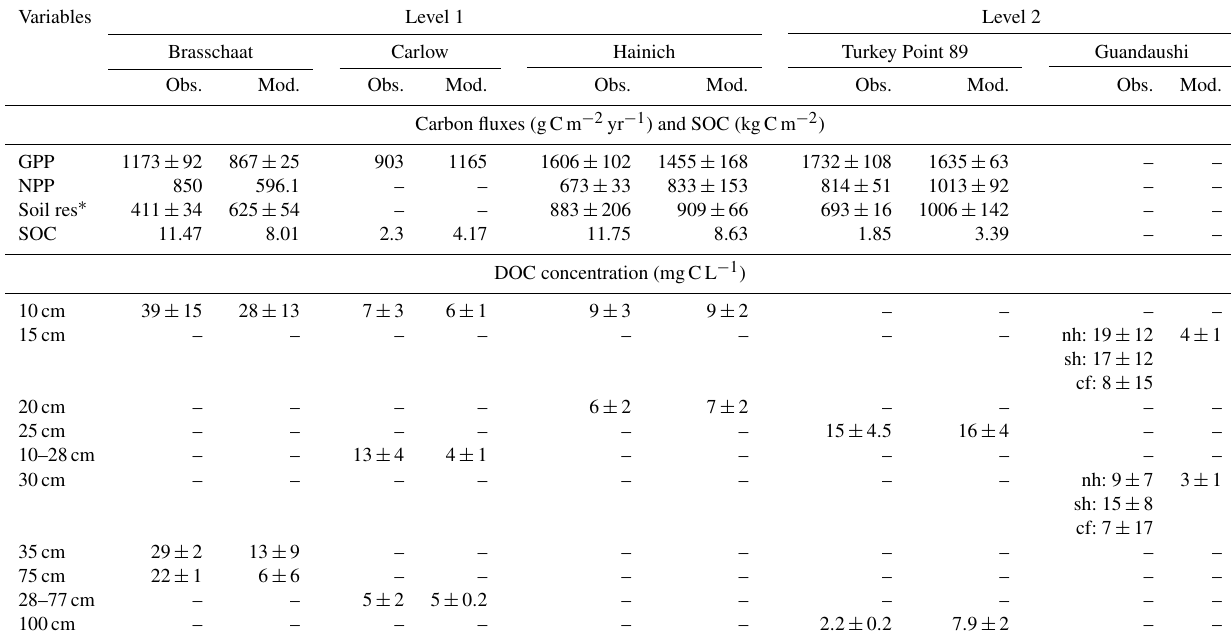
Table 5. The measured (Obs.) versus the modelled (Mod.) carbon fluxes, SOC concentration, and soil DOC concentration at different soil depths in five study sites.